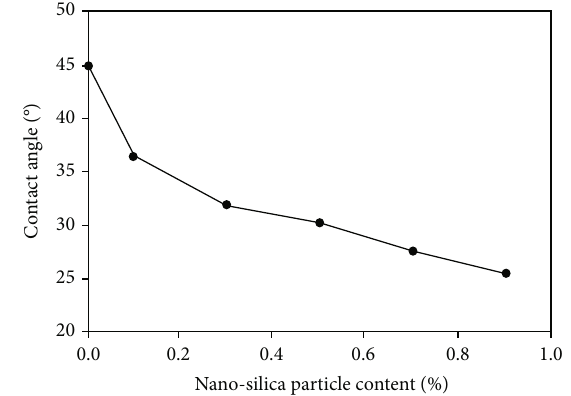
Figure 5: Relationship between nanosilica particle content and contact